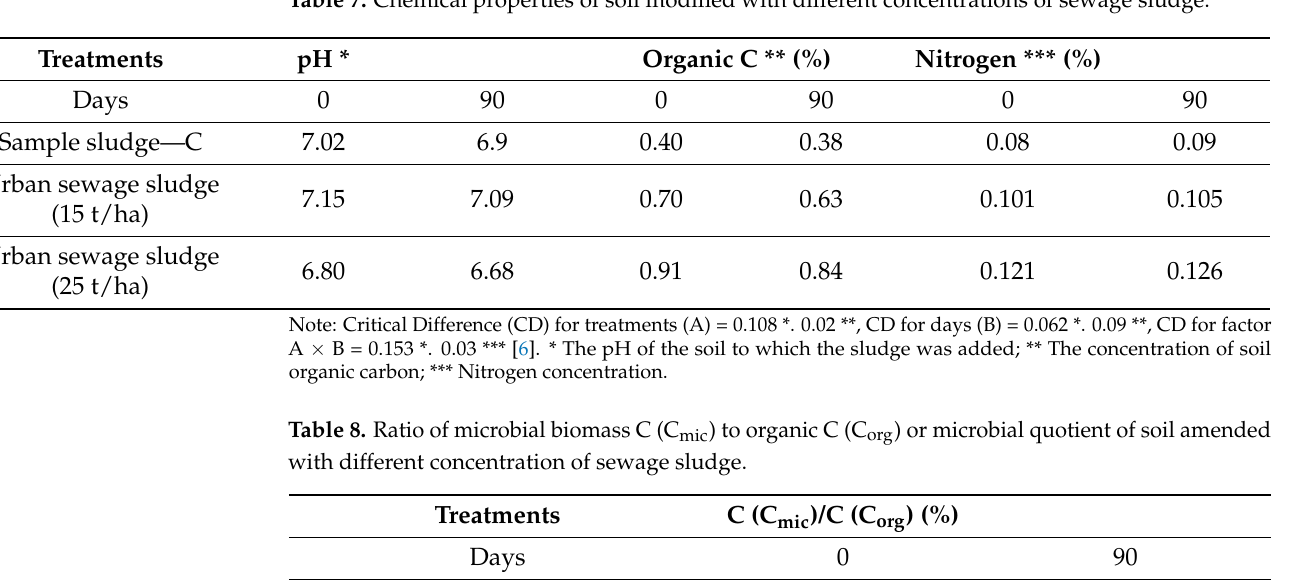
Table 7. Chemical properties of soil modified with different concentrations of sewage sludge.